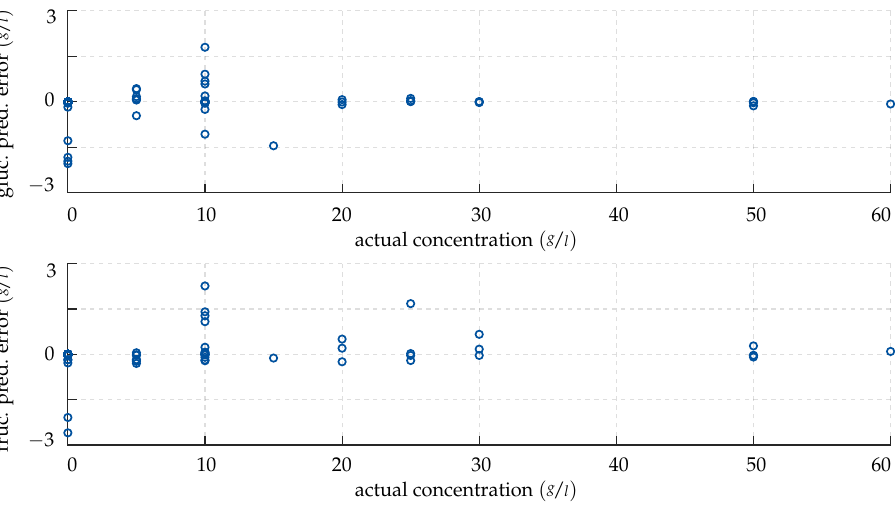
Figure 11. Prediction error made by the GPR for the test data. ( Top panel ) deviation in the pre- dicted glucose concentration plotted over the actual concentration. ( Bottom panel ) deviation in the predicted fructose concentration plotted over the actual